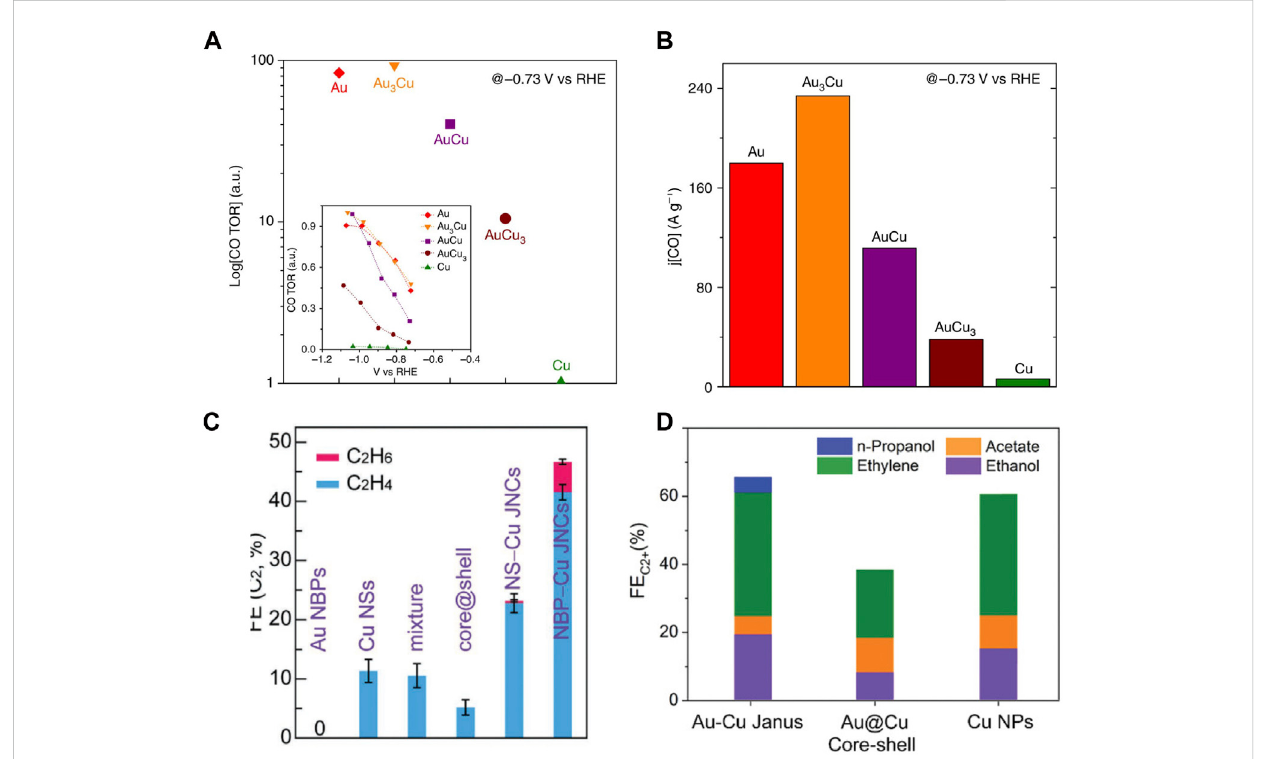
FIGURE 5 (A,B) Relative turnover rates and mass activity for CO of the Au – Cu alloy nanostructures (Kim et al., 2014). (C) Plot of faradaic ef fi ciency for C products for Au bipyramids, Cu nanospheres, Au – Cu core-shell nanospheres, and Au nanosphere – Cu heterodimers (Jia et al., 2021). (D) Plot of faradaic ef fi ciency for C 2 products for Au – Cu Janus, Au – Cu core-shell and Cu nanoparticles (Zheng et al.,